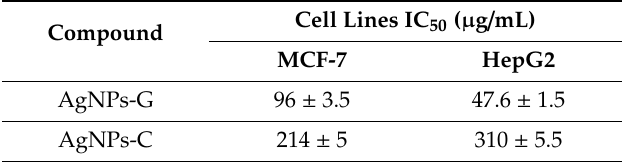
Table 2. IC 50 outcome for GNPs and Ag NPs for anticancer activity